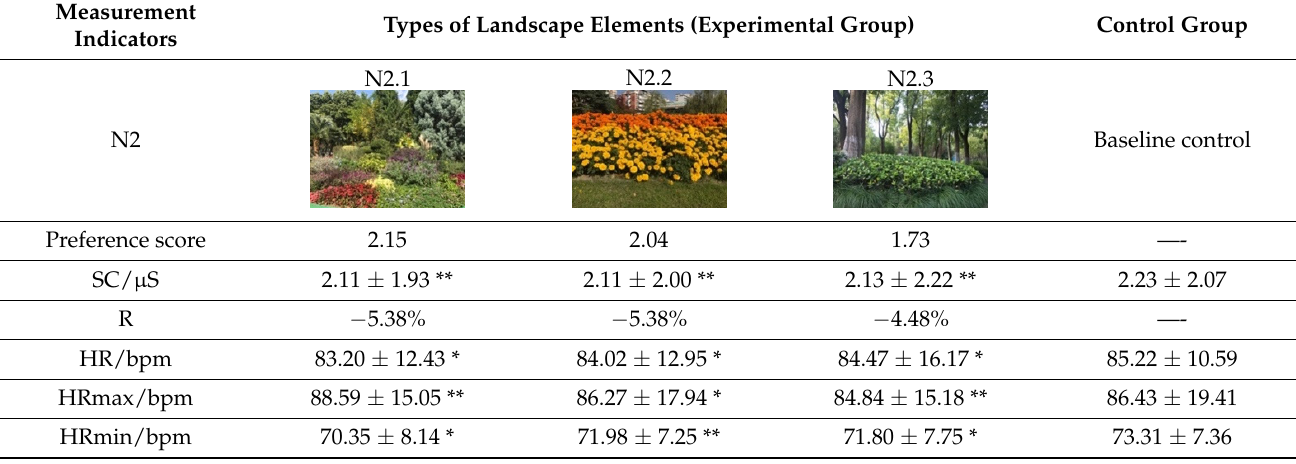
Table 9. Physiological indicators of participants before and after the measurement of plant color in different groups. Measurement Indicators